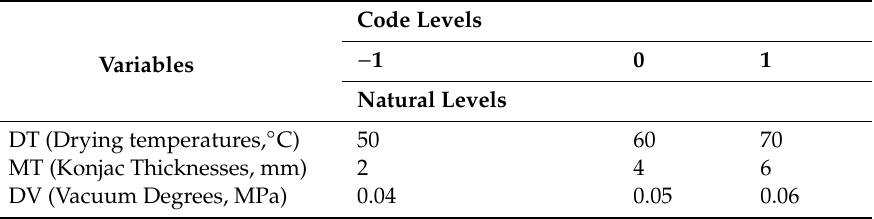
Table 1. Experimental design for vacuum drying of konjac.